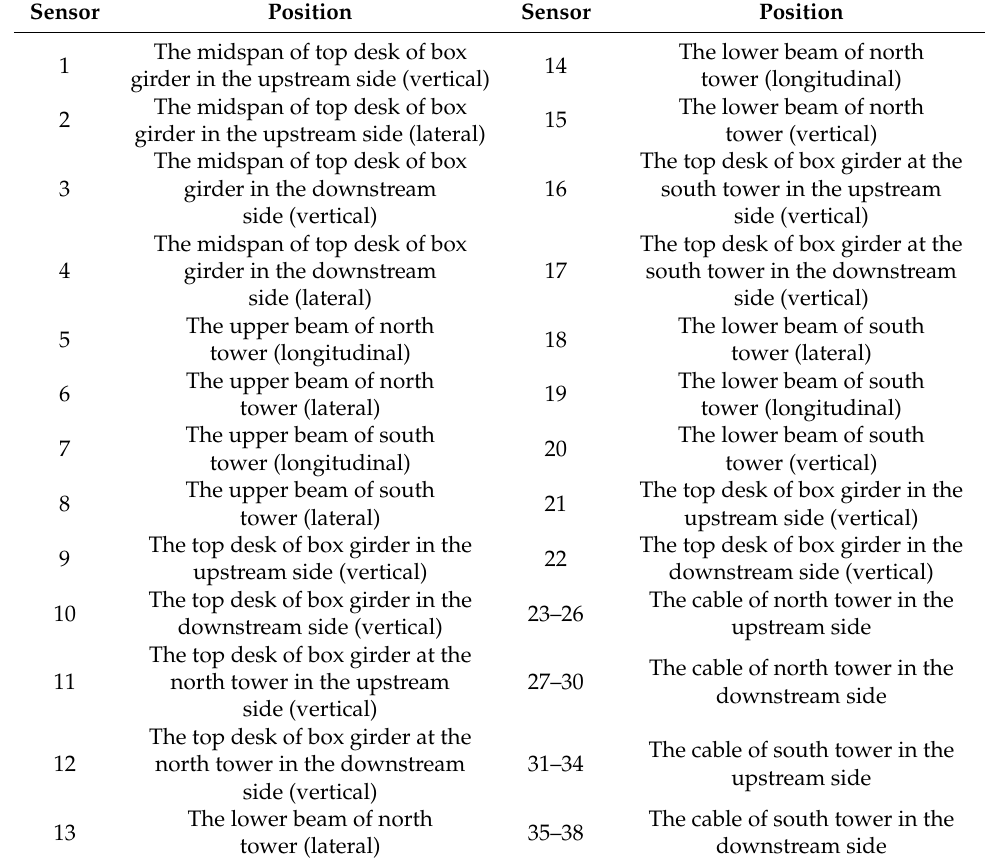
Table 1. The specific position of the acceleration sensor on the bridge. Sensor